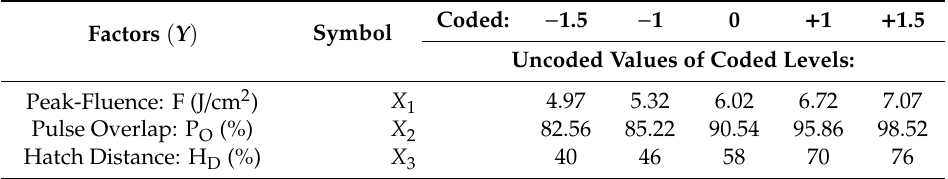
Table 1. Factors and their adopted (uncoded) values at di ff erent coded